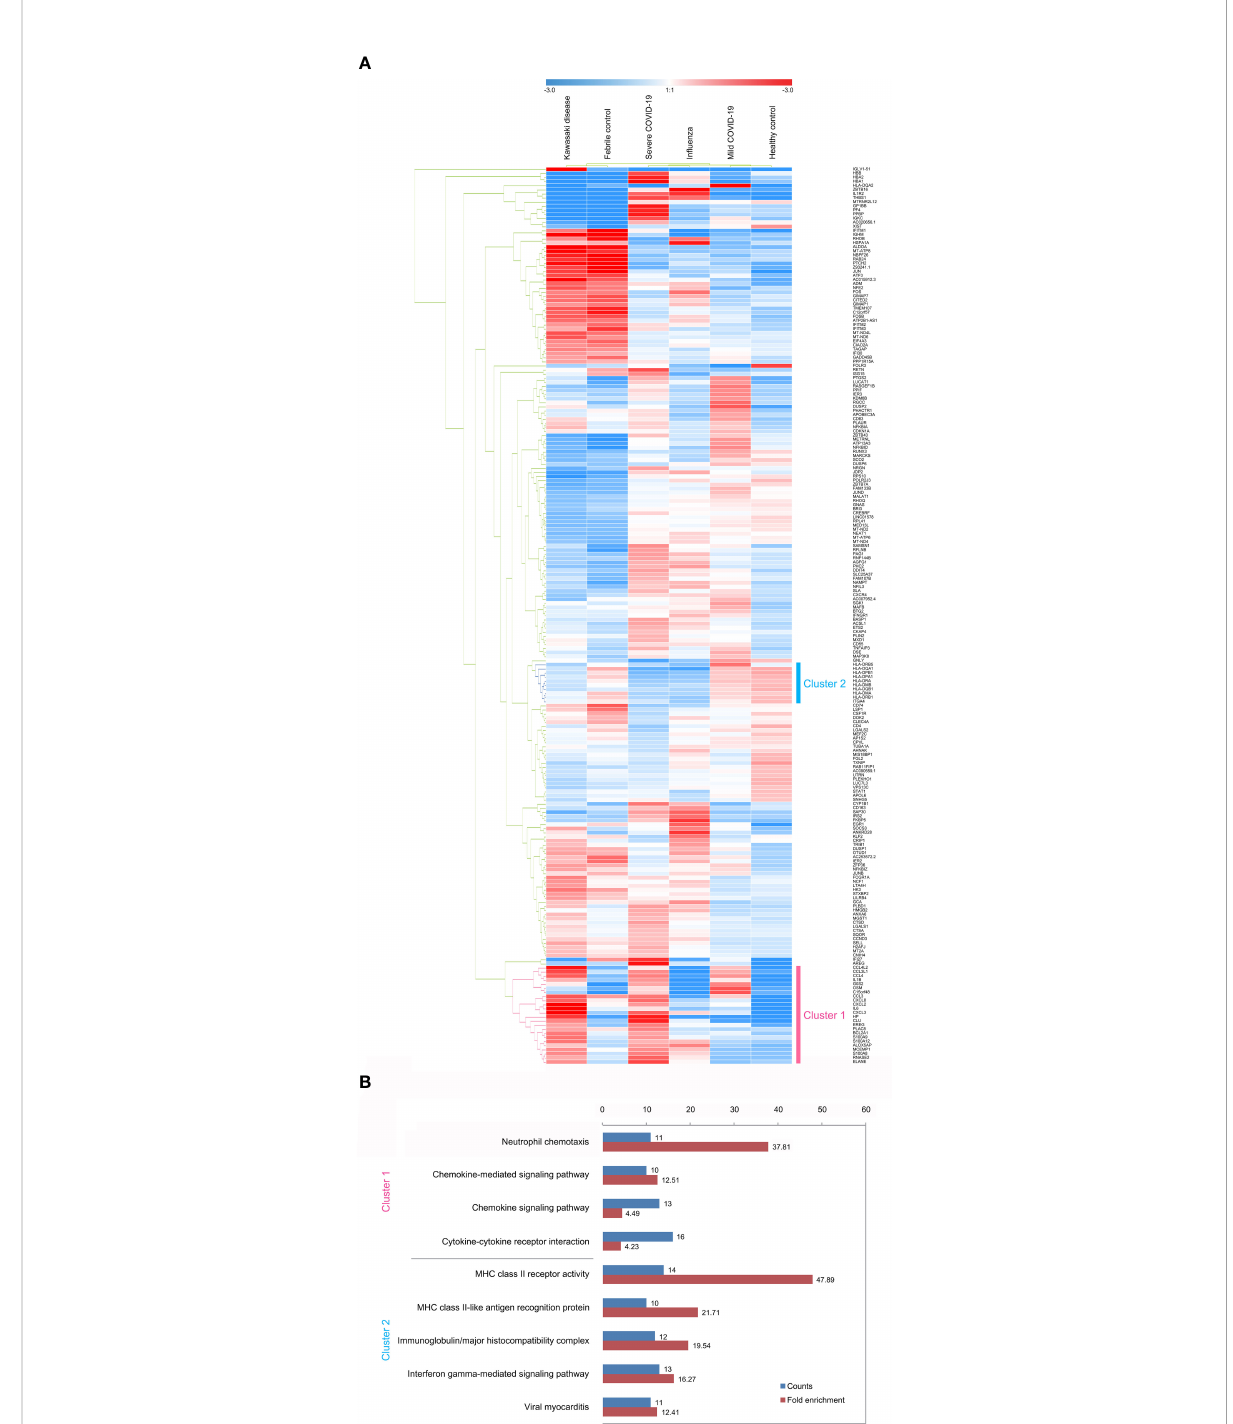
FIGURE 3 Subpopulation analysis of neutrophils. (A) Heatmap of 219 differentially expressed genes in neutrophil subsets across disease conditions (KD, FC, severe COVID-19, mild COVID-19, FLU, and HC). The color bars indicate gene expression clustered by hierarchical clustering for normalized gene expression levels. Cluster 1 genes (pink) represent heightened levels, whereas cluster 2 genes (cyan) are drastically reduced in both KD and severe COVID-19 compared to the controls (FC and HC, respectively). (B) The lists of over-represented gene ontology function of the two closely clustered genes featured by the DAVID annotation tool. The fold enrichment is de fi ned as the ratio of the two proportions, where one is the proportion of the input 219 DEGs belonging to a certain GO term, and the other is the proportion of genes in the universal background belonging to that speci fi c GO term. Adjusted p values are calculated from modi fi ed Fisher ’ s exact test with FDR multiple-testing